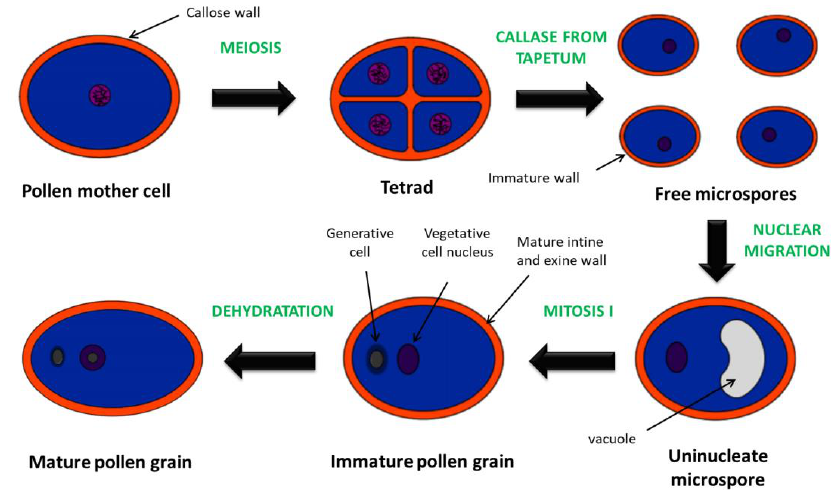
Figure 3. Main events during microsporogenesis of most angiosperms. Pollen mother cells undergo meiosis to form a tetrad. Individual microspores are released by the action of the callase from tapetum. Then, uninucleate microspores undergo mitosis I to form pollen with a larger vegetative cell and a smaller generative cell [17,24].